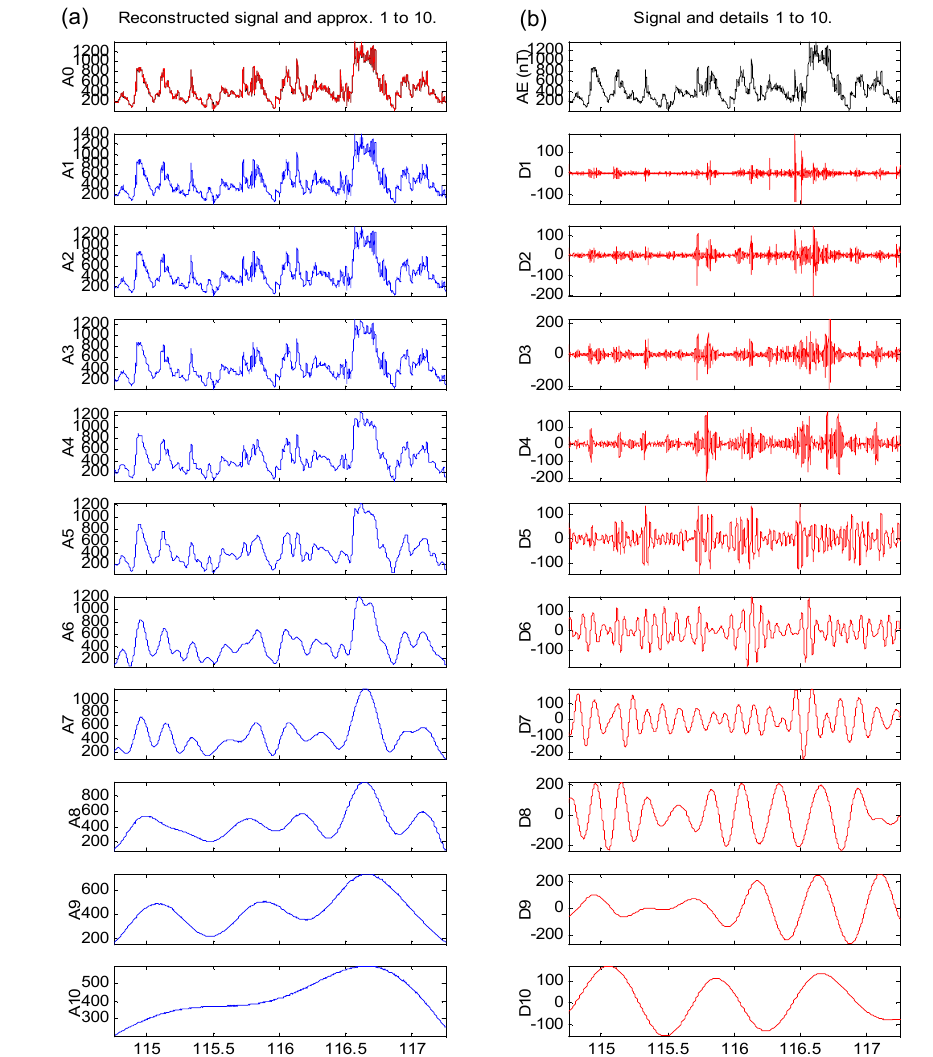
Figure 1. Wavelet decomposition of the AE index for event 1_1998. The right side shows the “details” (bands) and the left side shows the “approximations”